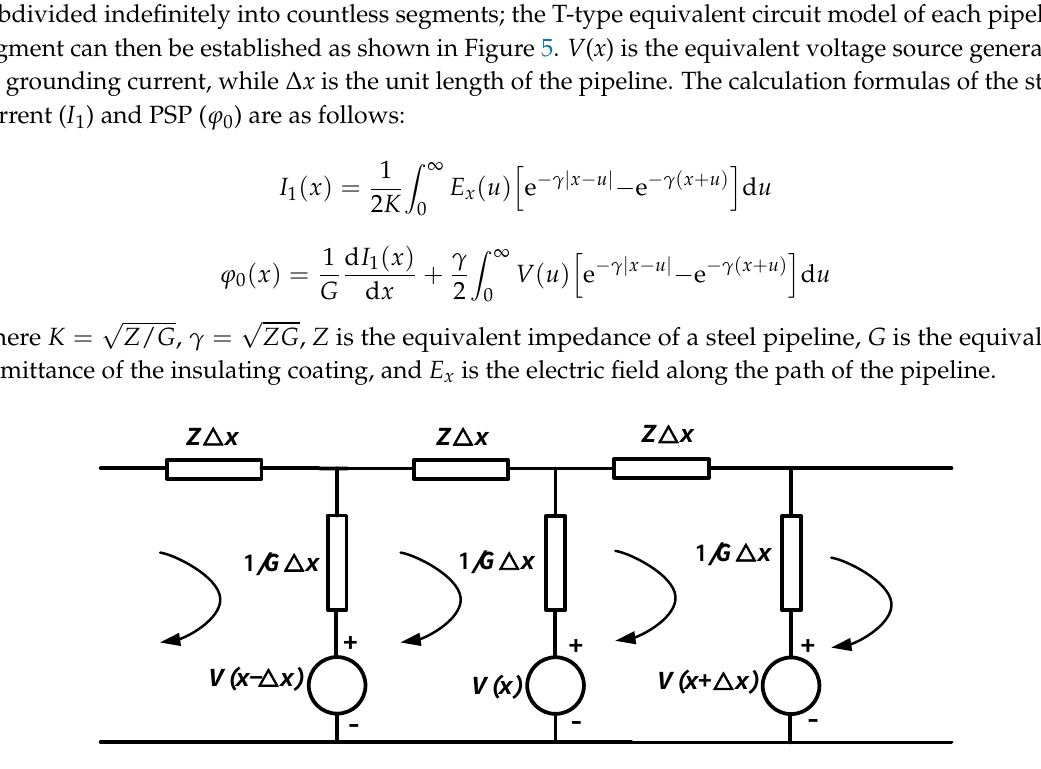
Figure 5. Equivalent circuit model of the pipeline.